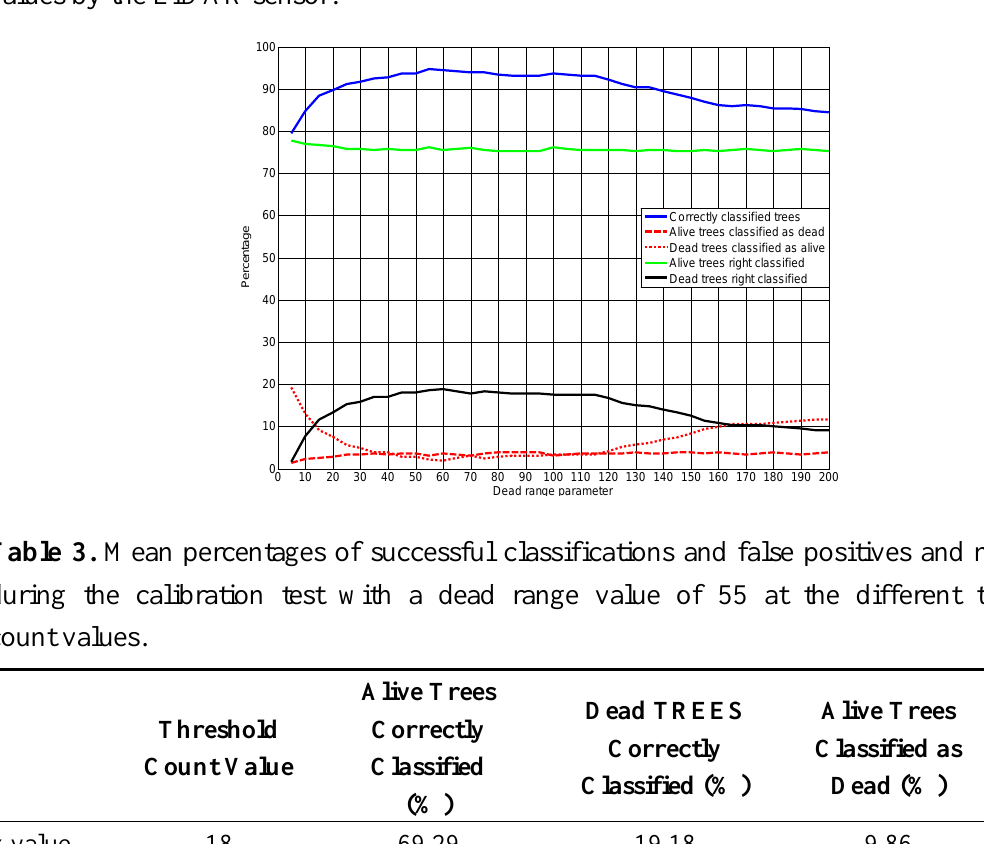
Figure 5. Classification tree percentages obtained for the different dead range parameter values by the LIDAR sensor.